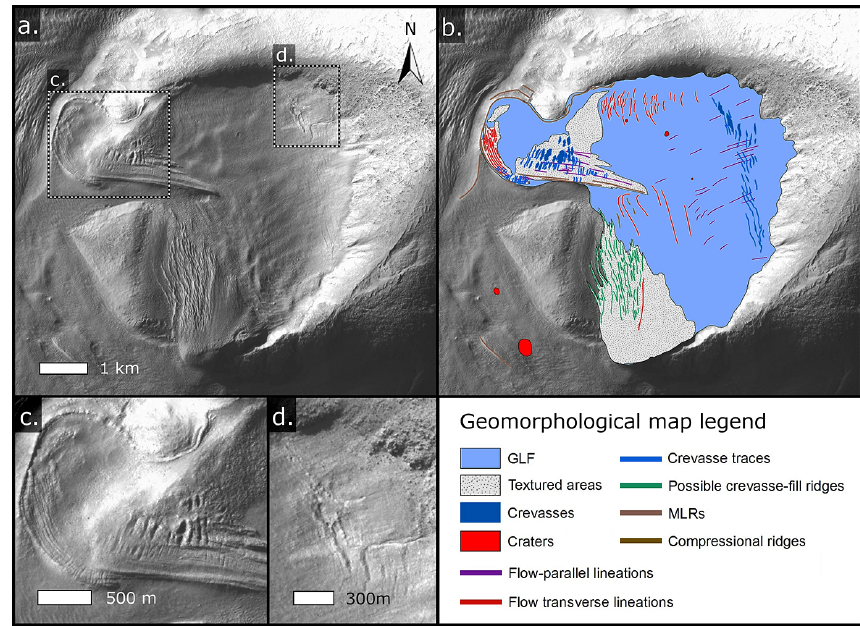
Figure 6. CTX image of crevassed GLF #1054, located in eastern Hellas (Fig. 5a) (a) , along with its geomorphological interpretation (b) and expansions of two crevasse sets ( c and d ).